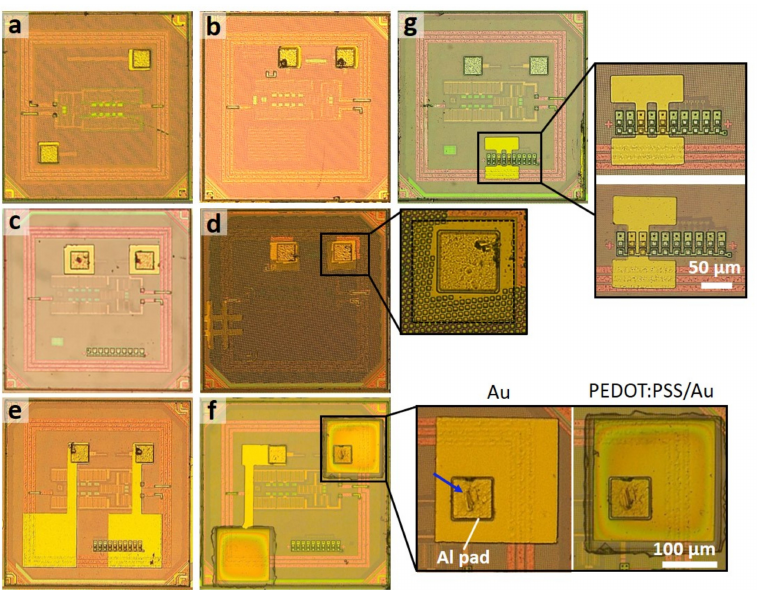
Figure 5. Examples of post-processed Au-micropatterns on chips with di ff erent electrode sizes and layouts: ( a,b ) pair of 70 µ m square pads, ( c,d ) pair of 100 µ m square pads, and ( e,f ) the